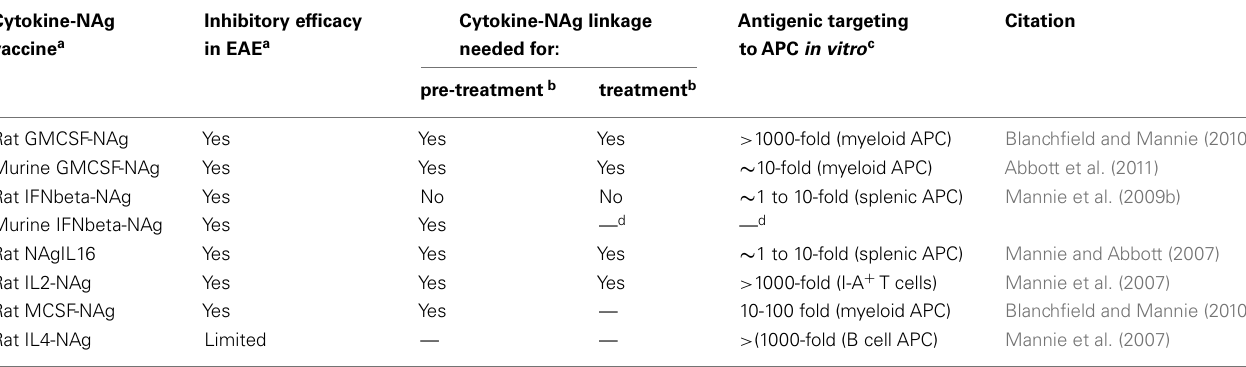
Table 2 | Summary of cytokine-NAg vaccines tested in